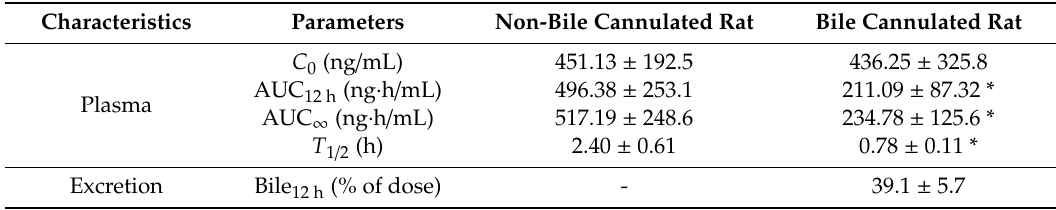
C 0 : initial plasma concentration; AUC 12h or AUC ∞ : area under the plasma concentration-time curve from 0 to last sampling time or infinity; T 1 / 2 : half-life. Data expressed as mean ± standard deviation from four rats. *: p < 0.05 compared with non-bile cannulated rat